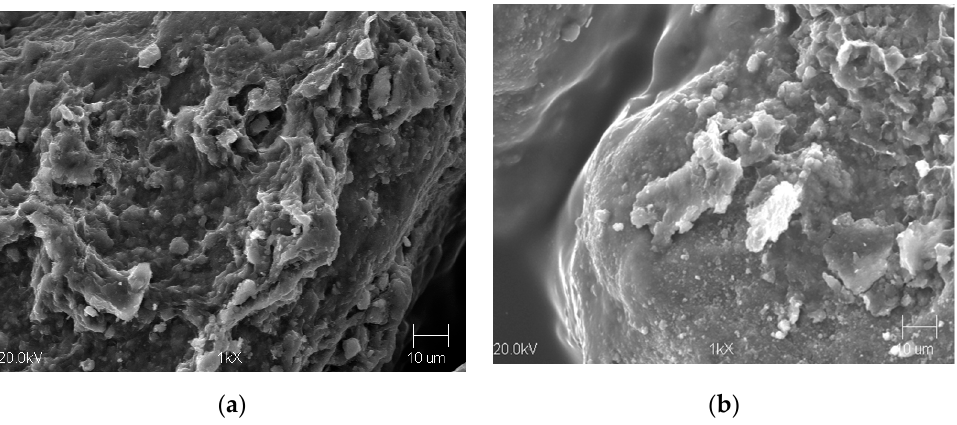
Figure 4. Surface morphology of used sand grains ( a ) and regenerate ( b ) obtained after 2000 h of operation time of the USR-I device; 1000× magnification.